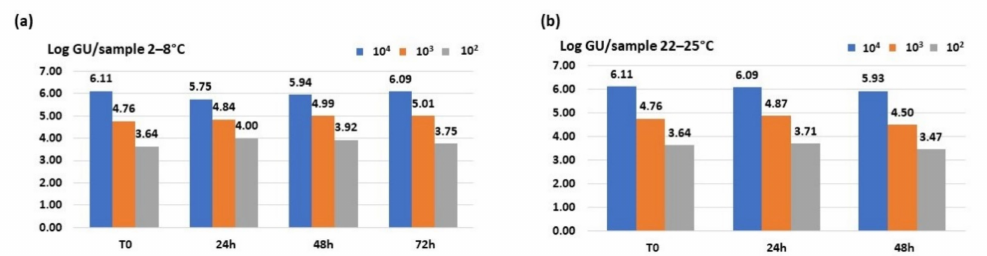
Figure 3. Genomic units/sample detected from 10 4 , 10 3 and 10 2 CFU/mL dilutions stored at ( a ) 2–8 ◦ C ( b ) and 20–25 ◦ C using qualyfast ® Legionella qPCR detection